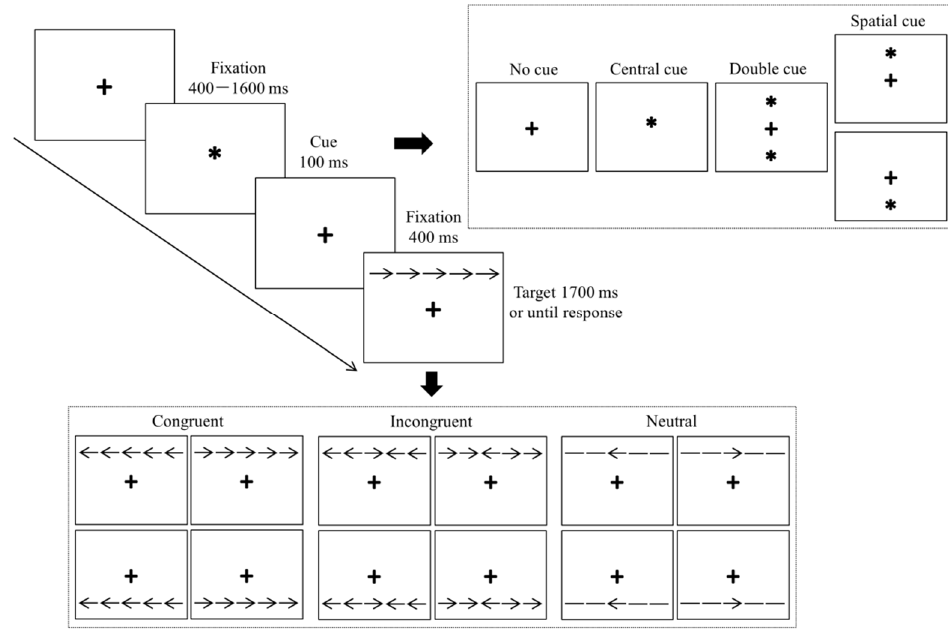
Figure 1. Sequence within a single trial of the attention network